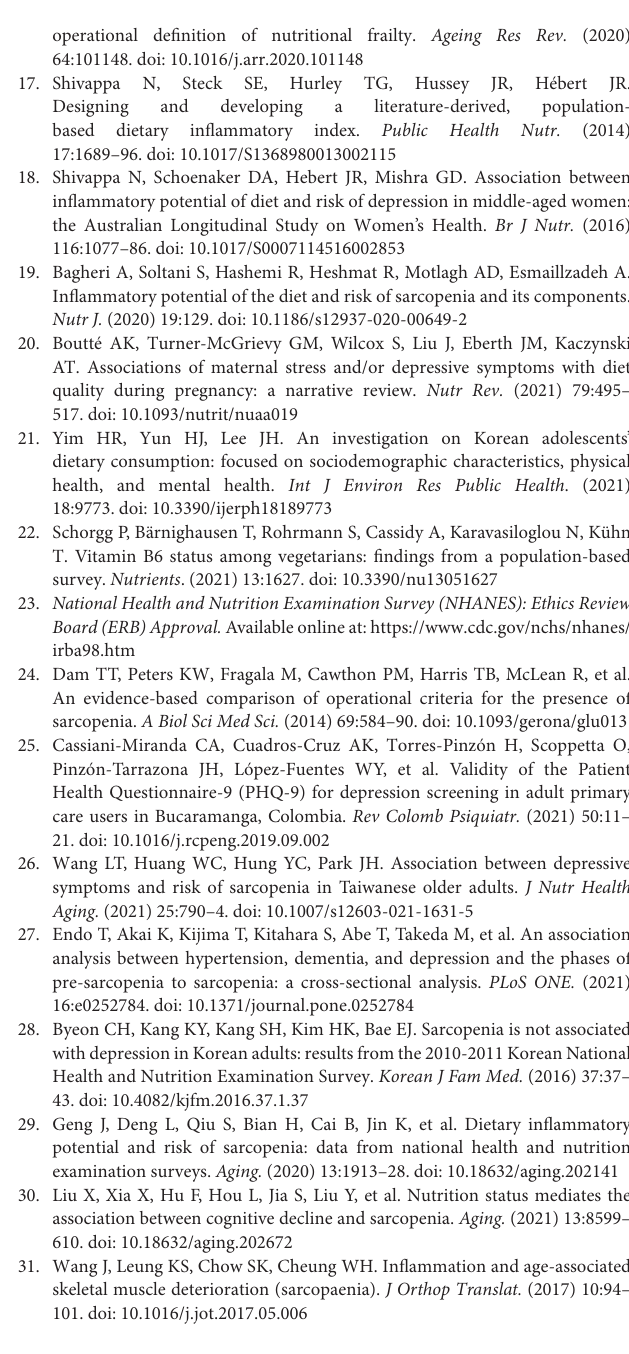
Supplementary Figure 1 | Flow chart of the study sample. Supplementary Table 1 | Association between depressive symptoms and sarcopenia stratified by categories of